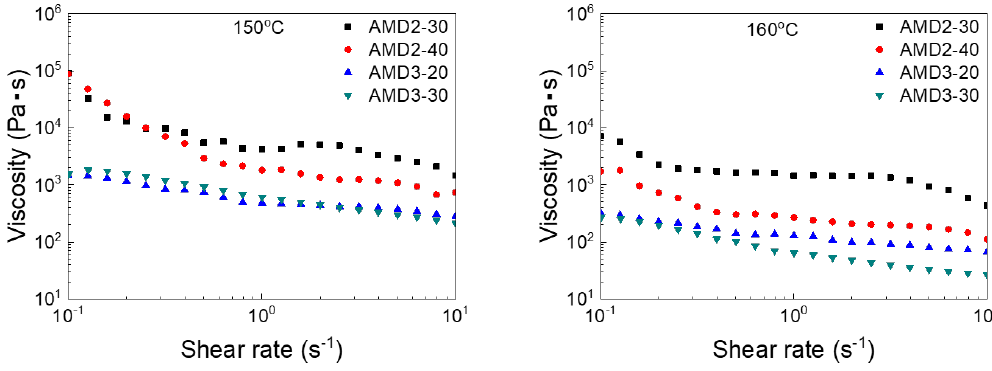
◦ C ( left ); and 160 ◦ C ( right